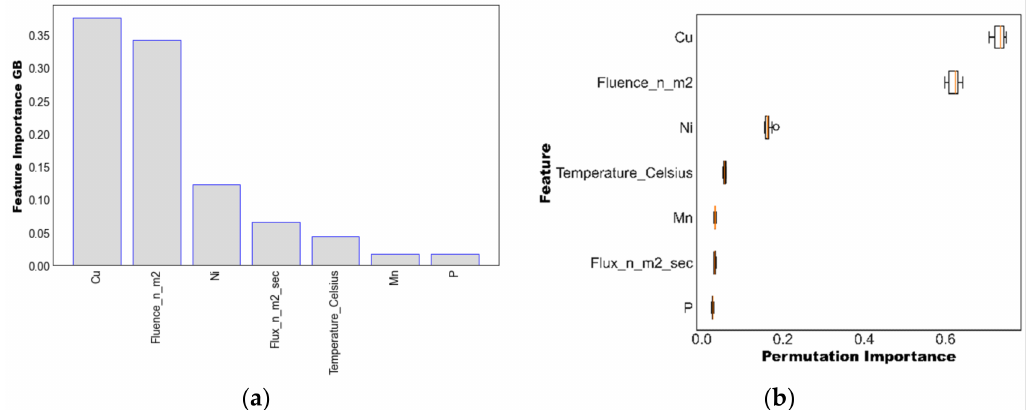
Figure 10. ( a ) Impurity-based and ( b ) permutation-based feature importance obtained from the optimized GB model.